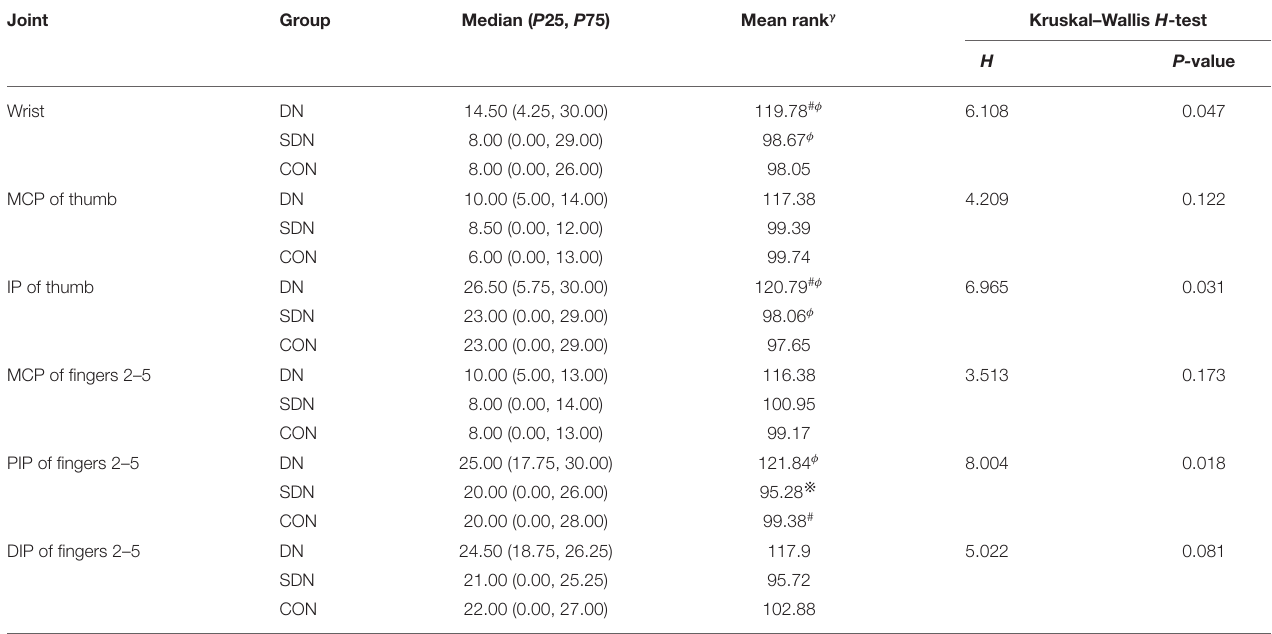
TABLE 9 | Change of joint flexion angles in resting position from baseline to week